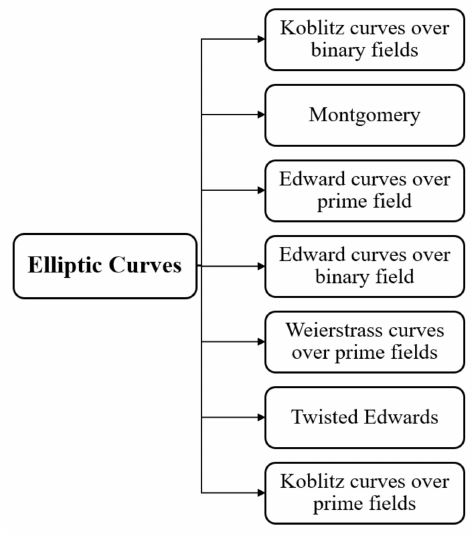
Figure 1. Illustration of special elliptic curve types, adopted from